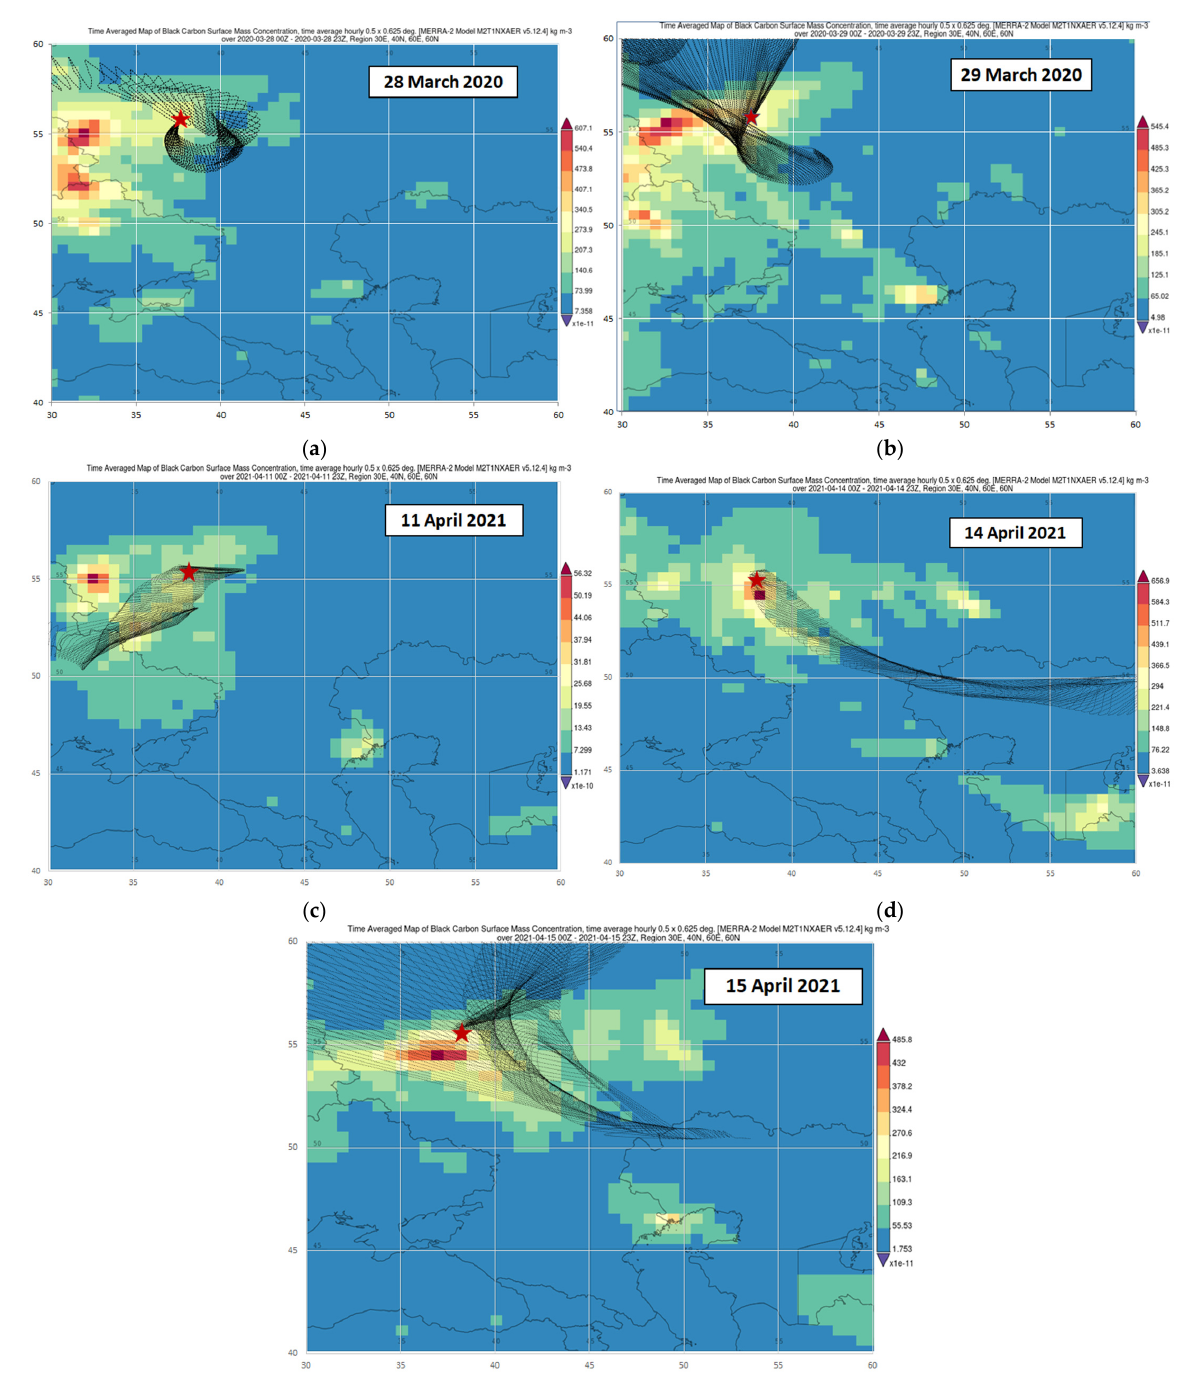
Figure 7. Examples of BC distributions (as an indicator of fire emissions) in near-surface atmosphere over ETR territory (according to MERRA-2 reanalysis [81]) and trajectories of air mass transport (black dots) to Moscow (asterisk) for individual days from episodes No. 1 ( a , b ), No. 4 ( c – e ). The color scales of BC concentration on the maps are different, kg/m 3 .